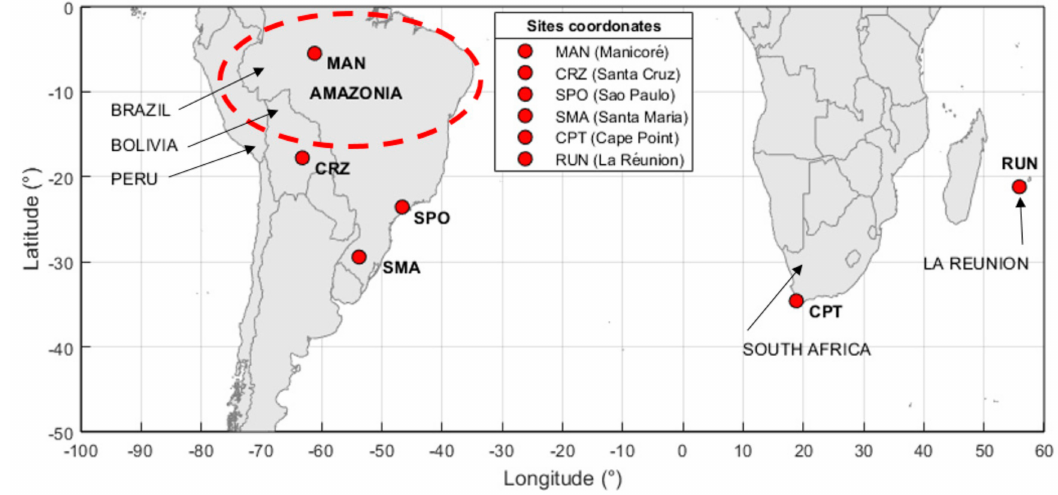
Figure 1. Map of the study area (Southern America, Atlantic Ocean, Southern Africa and South-West Indian Ocean), together with study sites depicted with red circles (see the